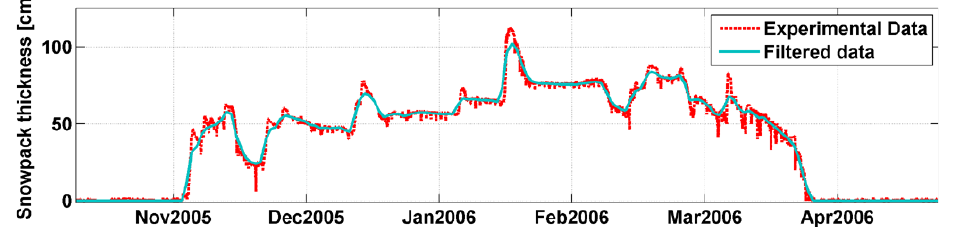
Fig. 5. Example of validation dataset: the experimental data, affected by sensor errors (above), are filtered with a moving average to clear out the noise and to estimate missing data.